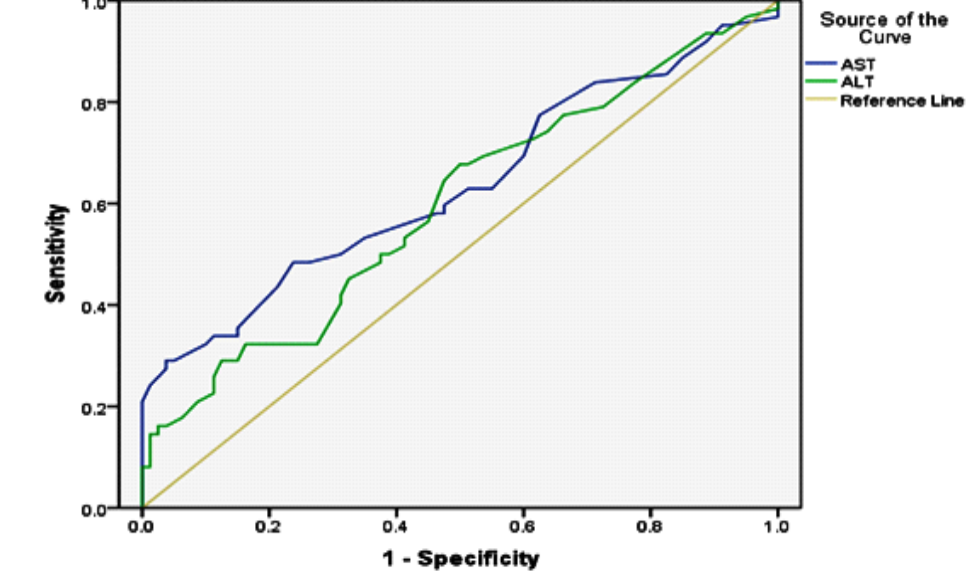
Figure 1. Receiver operating characteristic (ROC) curve of the levels of ALT (Alanine aminotransferase) and AST (Aspartate aminotransferase) in 142 hemodialysis patients. At cut-off points of 16.5 and 25.5 IU/L, ALT and AST could, respectively differentiate between patients with and without liver morbidity better than the conventional Upper Limit of Normal used in the